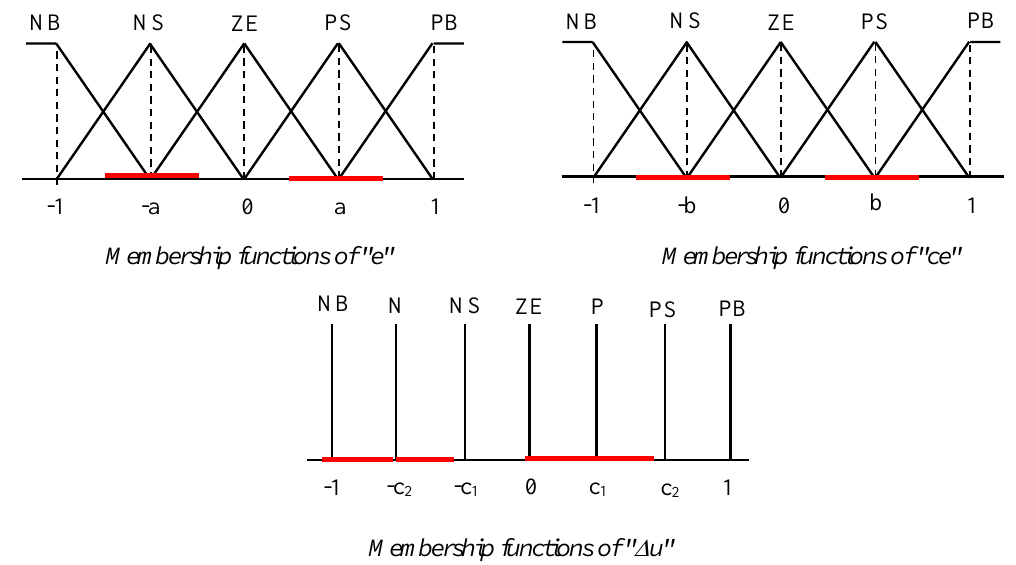
Figure 14. Optimizing the membership functions of the FLC-Sugeno controller using PSO